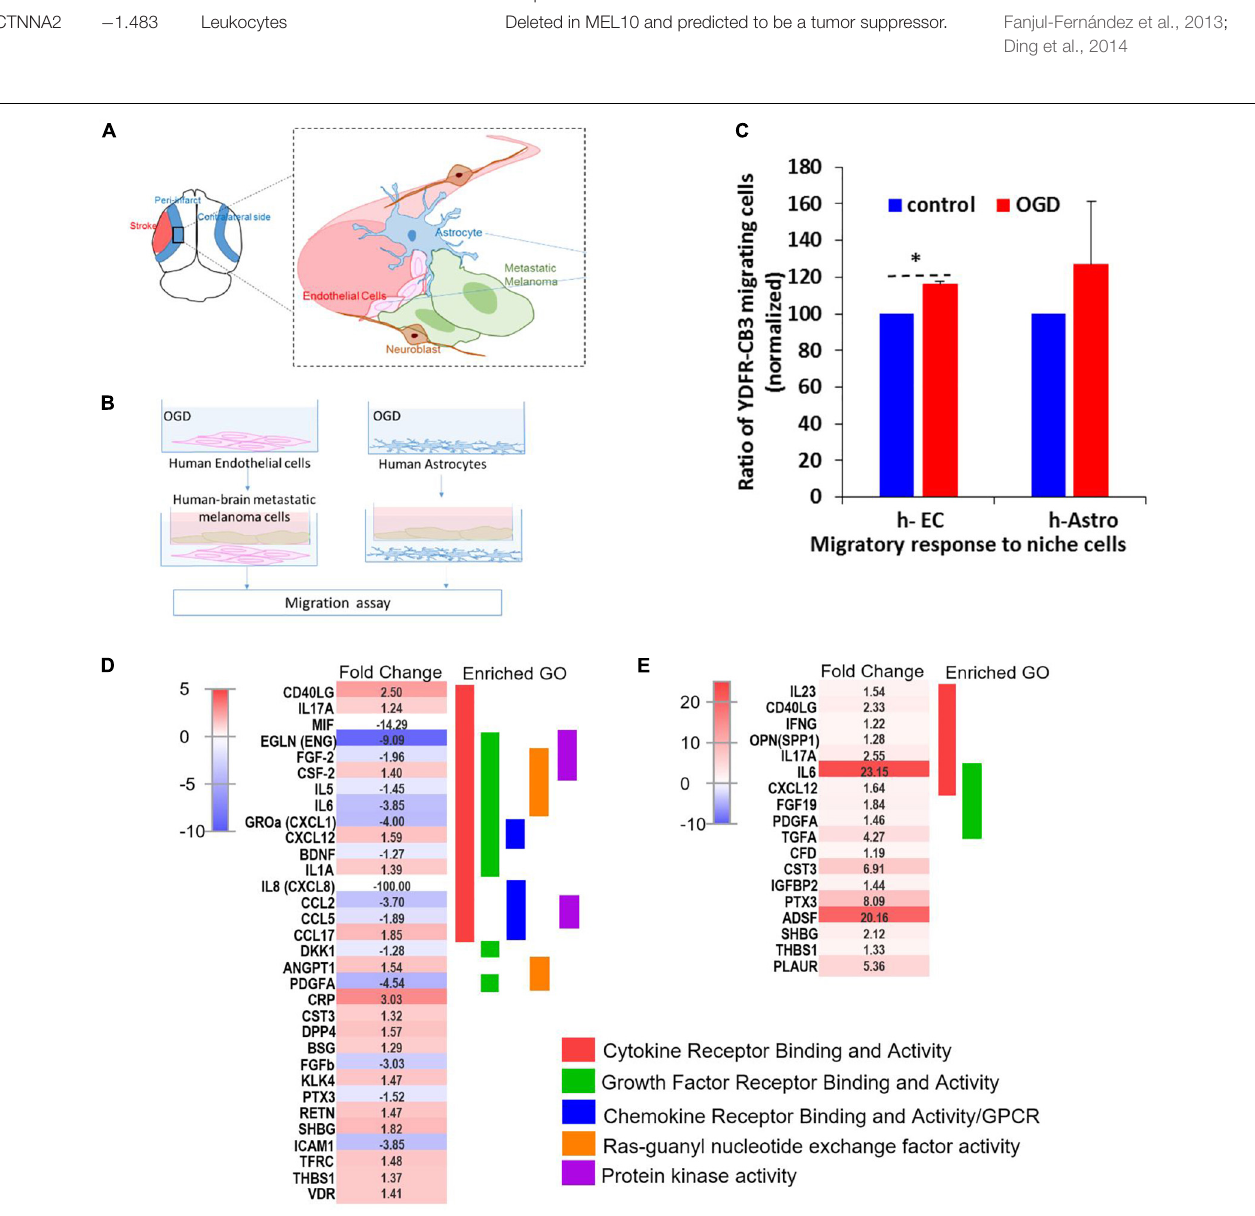
FIGURE 7 | OGD alters chemokine/cytokine responses in the neurovascular niche and enhances migration of brain metastatic cells. (A) Schematics showing the interaction of human astrocytes (h-Astro) and human endothelial cells (h-EC) with metastatic melanoma cells. (B) Schematics of method of oxygen glucose deprivation (OGD) conditioned media exposed to metastatic melanoma cells. (C) Migratory response of metastatic melanoma cells exposed to OGD conditioned media from cells are shown as mean ± SD, ∗ P < 0.05. (D,E) Heatmap of relative expression of secreted proteins profiled from the medium of h-Astro (E) and h-EC (D) . Functionally grouped enriched pathways are shown in one color. Enrichment/depletion tests performed with ClueGO application on cytoscape, κ score ≥ 0.4.